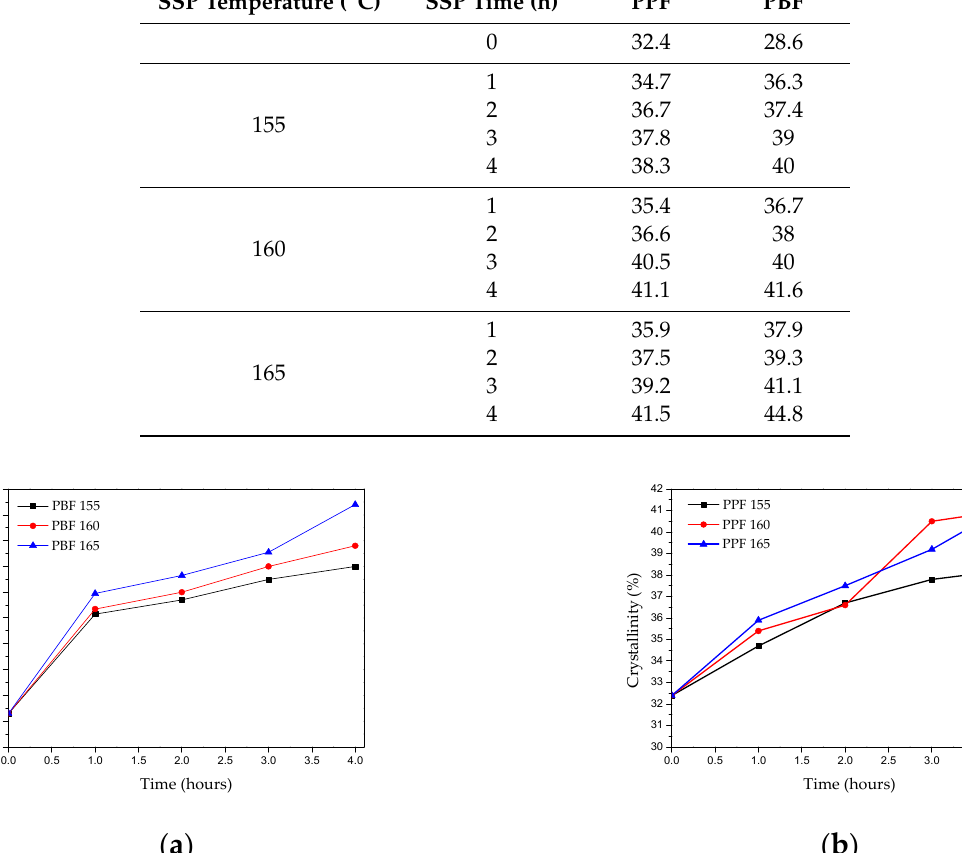
Figure 8. DSC thermograms of the prepared polyesters after SSP at 155 °C for ( a ) PBF, ( b ) PPF, after SSP at 160 °C for ( c ) PBF, ( d ) PPF and after SSP at 165 °C for ( e ) PBF, ( f ) PPF. Table 4. Crystallinity degree (%) of PPF and PBF samples after SSP. SSP Temperature ( ◦ C) SSP Time (h) PPF PBF